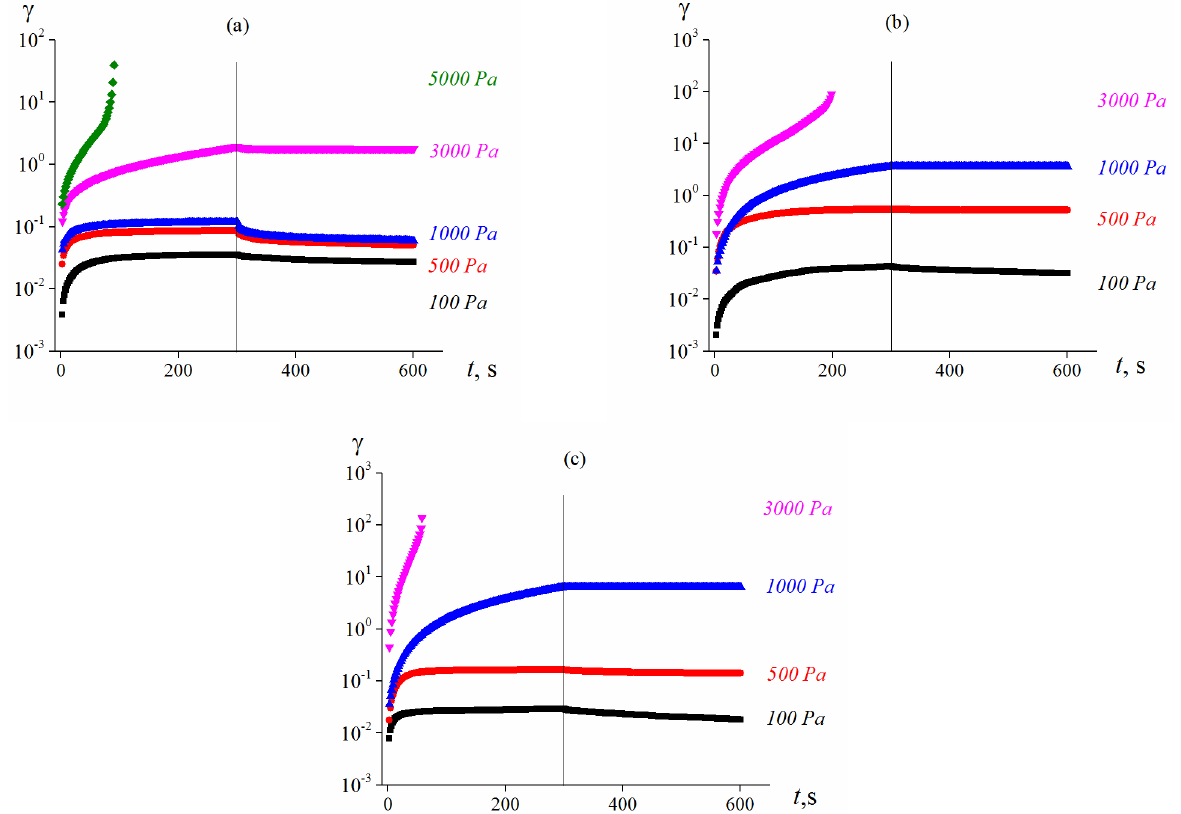
Figure 12. Development and recovery of deformation under constant shear stress and after its cessation at 100 ( a ), 120 ( b ) and 150 ◦ C ( c ) for compositions based on aluminum.